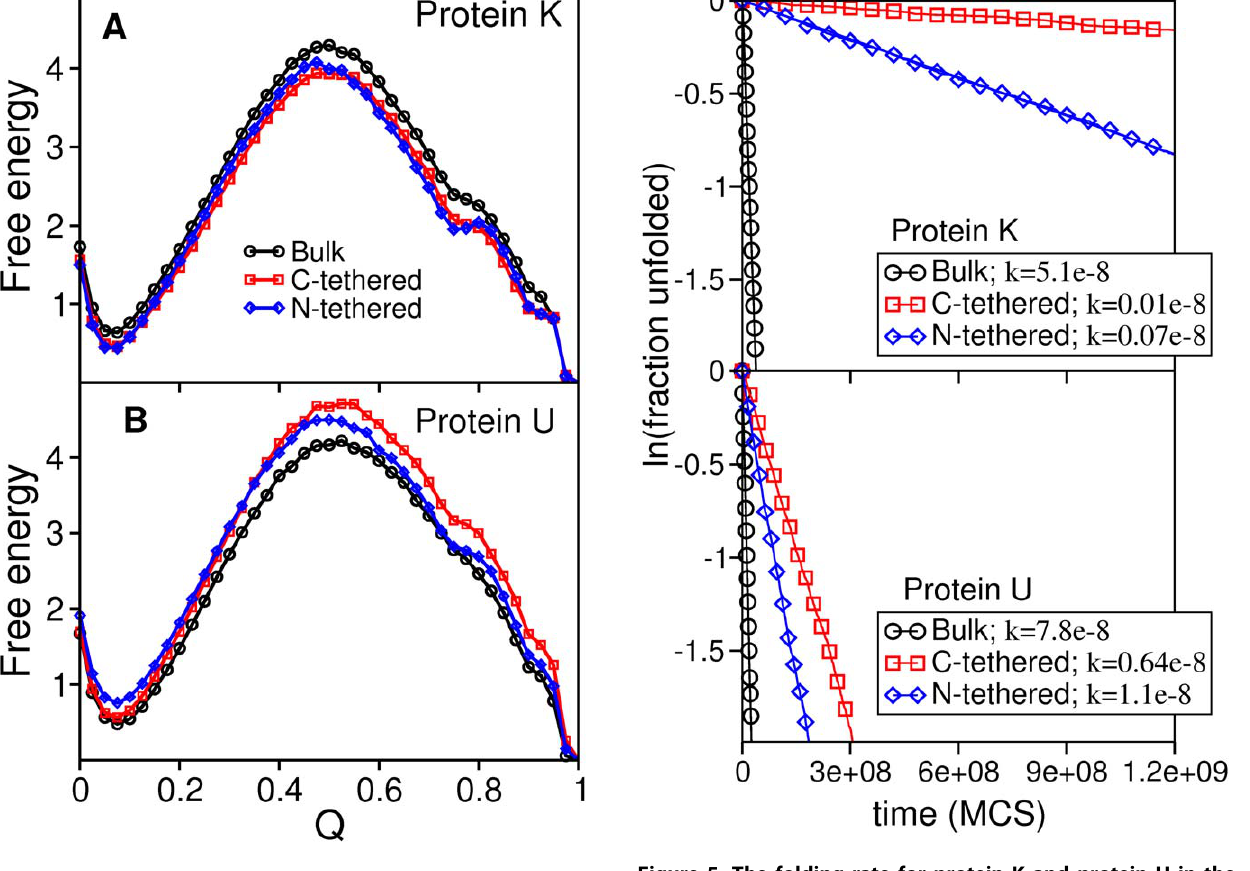
Figure 4. Free energy profiles. The free energy as a function of the fraction of native contacts for the knotted protein (A) and the unknotted one (B) evaluated at T m .